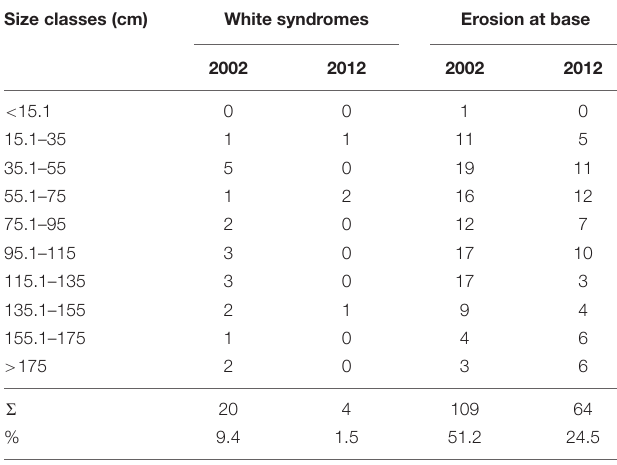
TABLE 2 | Absolute frequency of colonies of D. cylindrus with white syndromes or erosion at the base in 2002 and